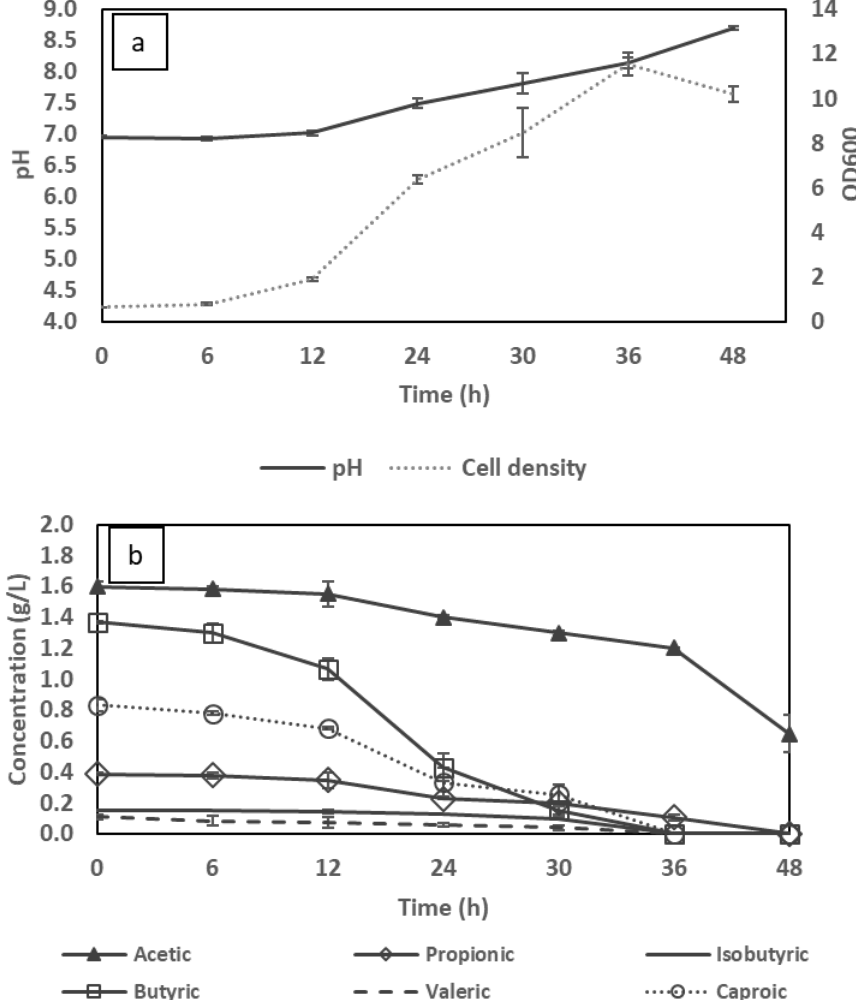
Figure 2. Changes in pH, cell density ( a ) and volatile fatty acid (VFA) concentration ( b ) during flask cultivation in the synthetic VFA mixture.